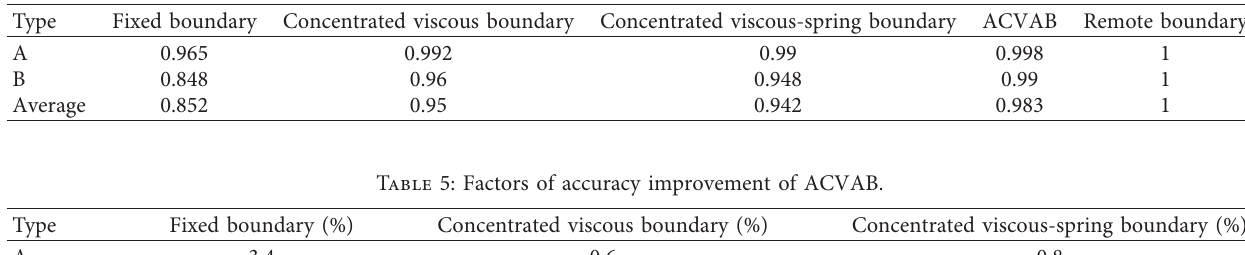
Table 4: Comparison of fitting accuracy of time history curve.